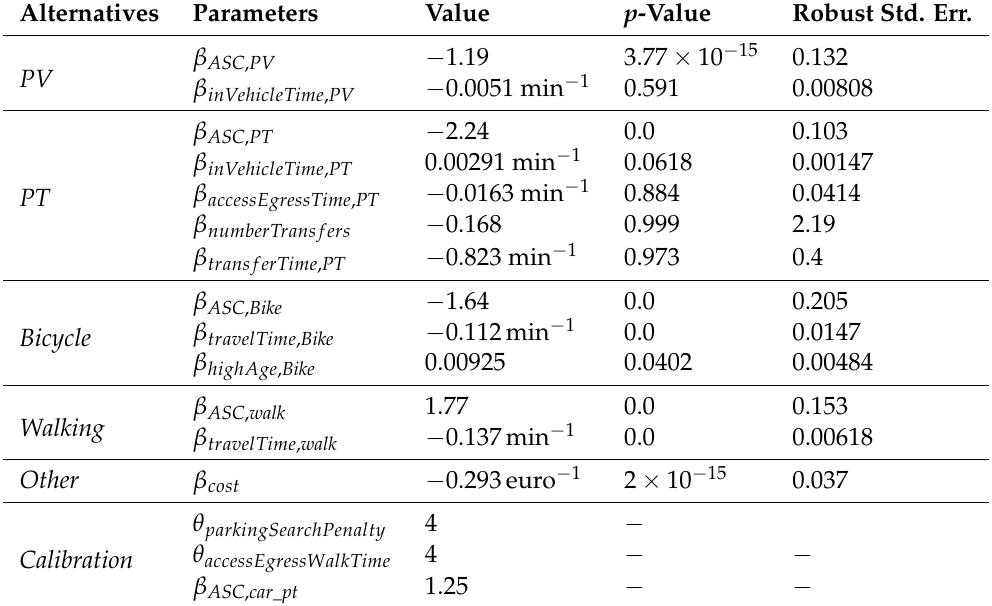
Table 1. Parameter values estimated with Biogeme software. Number of parameters: 13; sample size: 5.114; init log likelihood: − 8668.555; final log likelihood: − 5086.908; rho square: